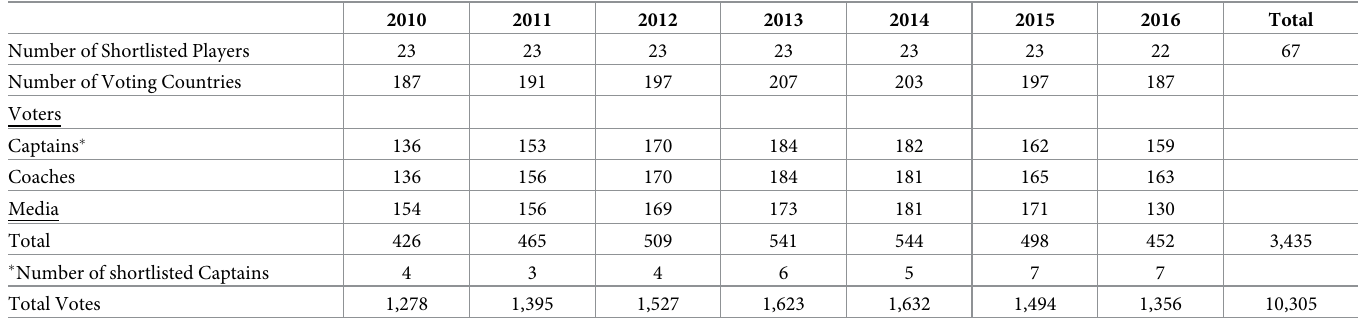
Table 1. FIFA dataset used to investigate voting